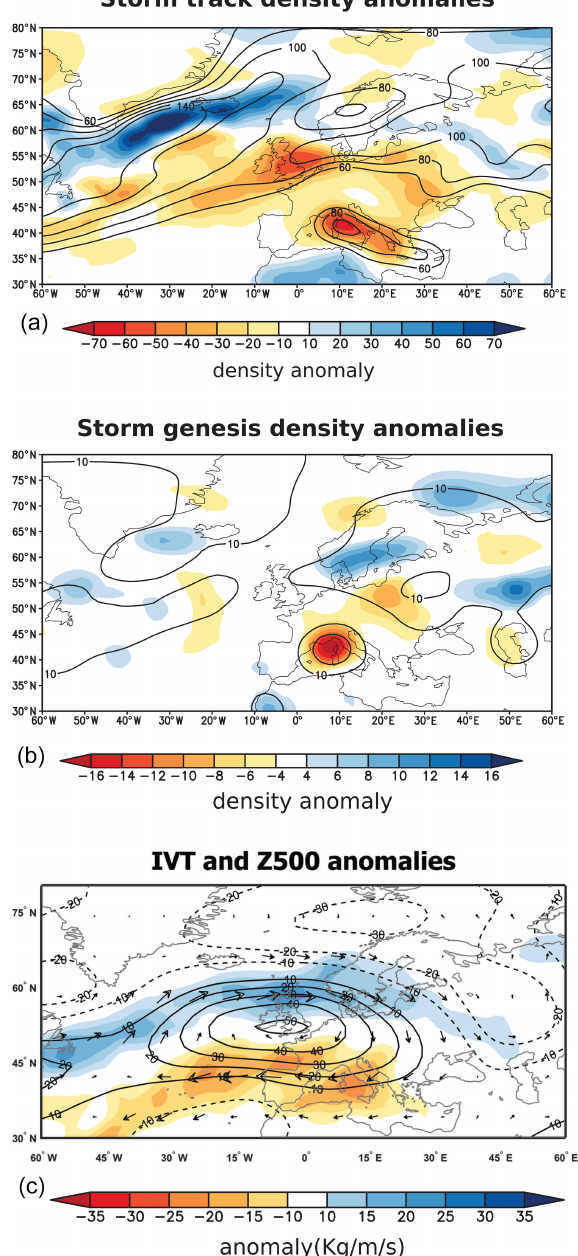
Figure 12. (a) 1921 storm track density anomaly (shaded) and storm track ERA20C density climatology (contours). Densities are in units of number of storm tracks per year, per unit area, where the unit area is equivalent to a 5 ◦ spherical cap ( ≈ 106km 2 ). (b) 1921 storm genesis density anomaly (shaded) and ERA20C genesis den- sity climatology (contours). Densities are in units of number of storm tracks or genesis events per year respectively, per unit area, where the unit area is equivalent to a 5 ◦ spherical cap ( ≈ 106km 2 ). (c) 1921 vertically integrated horizontal vapour transport anomaly intensity (shading) and transport direction (arrows). Contours show the 1921 Z500